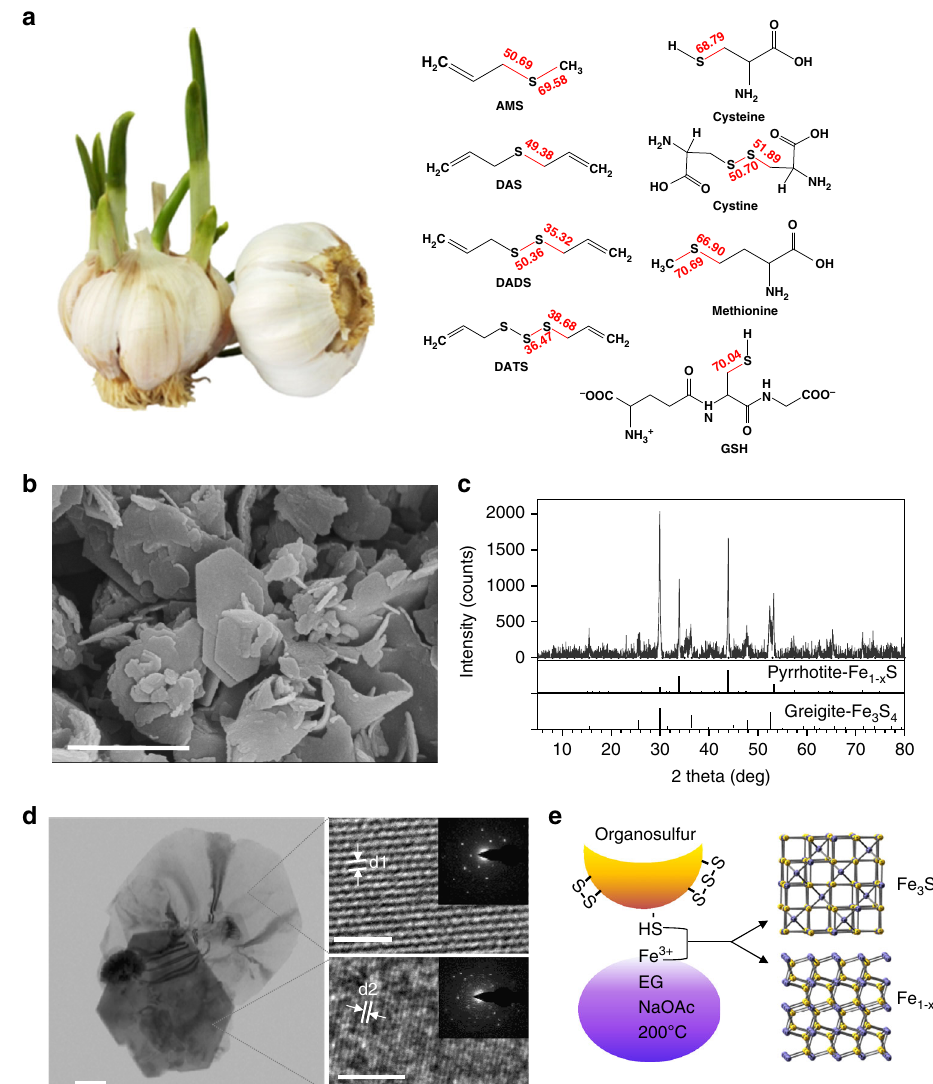
Fig. 1 Converting organosulfur compounds into nano-iron sul fi de (nFeS) by solvothermal synthesis. a Garlic-derived and other natural organosulfur compounds. The number in red is the computational calculated value of bond dissociation energy (BDE) for the S-related bonds (in kcal mol − 1 ). b The scanning electron microscope (SEM) image of nFeS with sheet-like hexagonal nanostructure. Scale bar: 1 µ m. c XRD characterization of nFeS in the two phases of Fe 1- x S and Fe 3 S 4 . d The transmission electron microscope (TEM) image (left image) of nFeS with high resolution characterization (right images) and single-crystal diffraction (inserted images). Left scale bars: 200 nm. Right scale bars: 2 nm. d1: d-spacing at 0.298 nm. d2: d-spacing at 0.15 nm. e Scheme of converting organosulfur compounds to nFeS with Fe 3 S 4 and Fe 1- x S. All experiments were performed in triplicate, and the representative images are